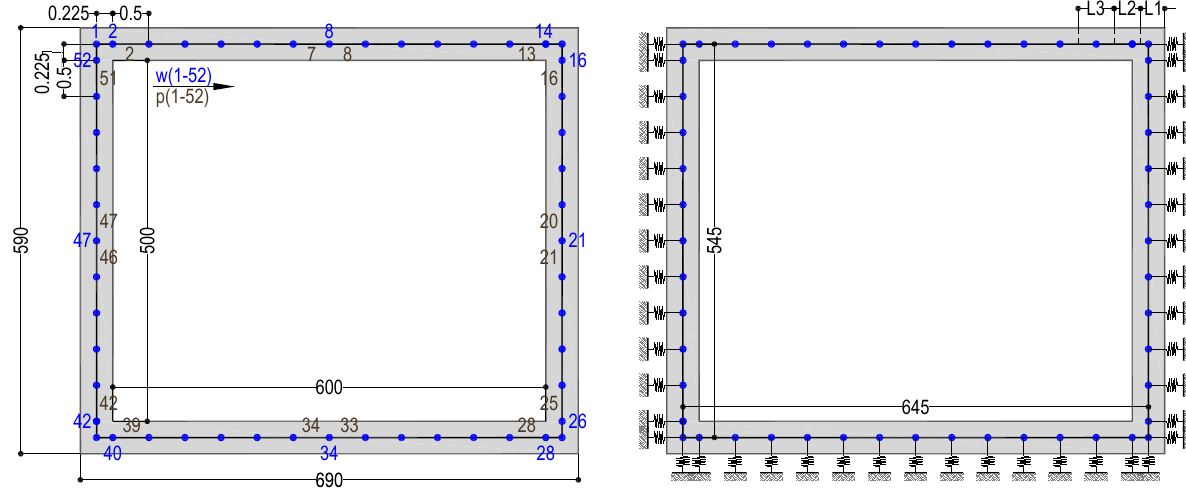
Figure 7: Beams and nodes location and elastic constraints distribution in cross-section.